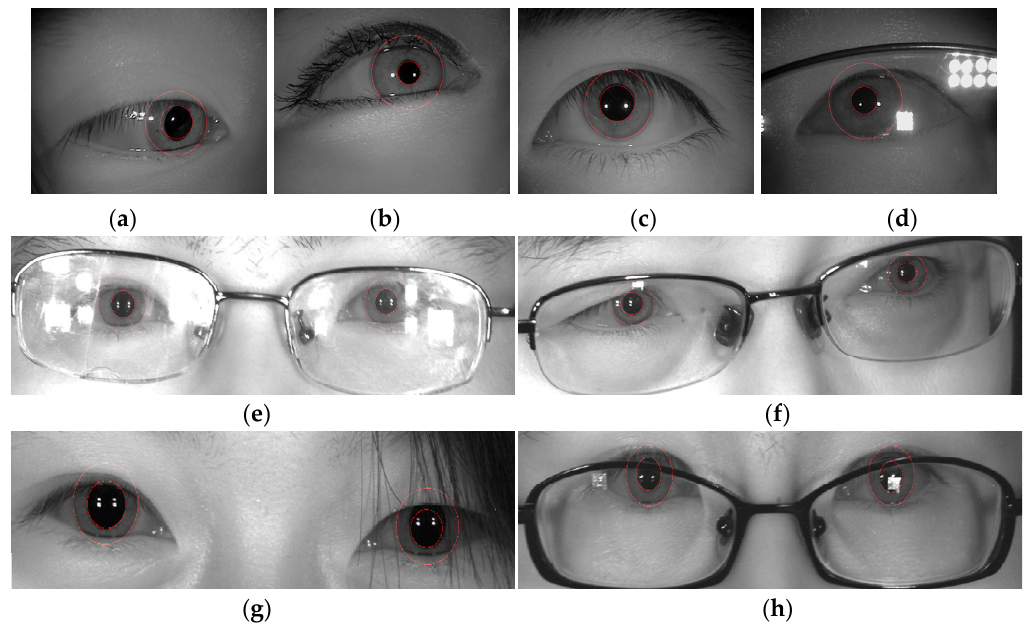
Figure 8. Inner and outer boundaries of iris localization by improved operators under non-cooperative environments [22]. ( a ) Off-angle iris; ( b ) iris obscured by eyelids; ( c ) iris interfered with by eyelashes; ( d , e ) iris with specular reflection; ( f ) off-angle iris at a long distance; ( g ) iris ob- struction due to hair; ( h ) glasses obstructing the iris